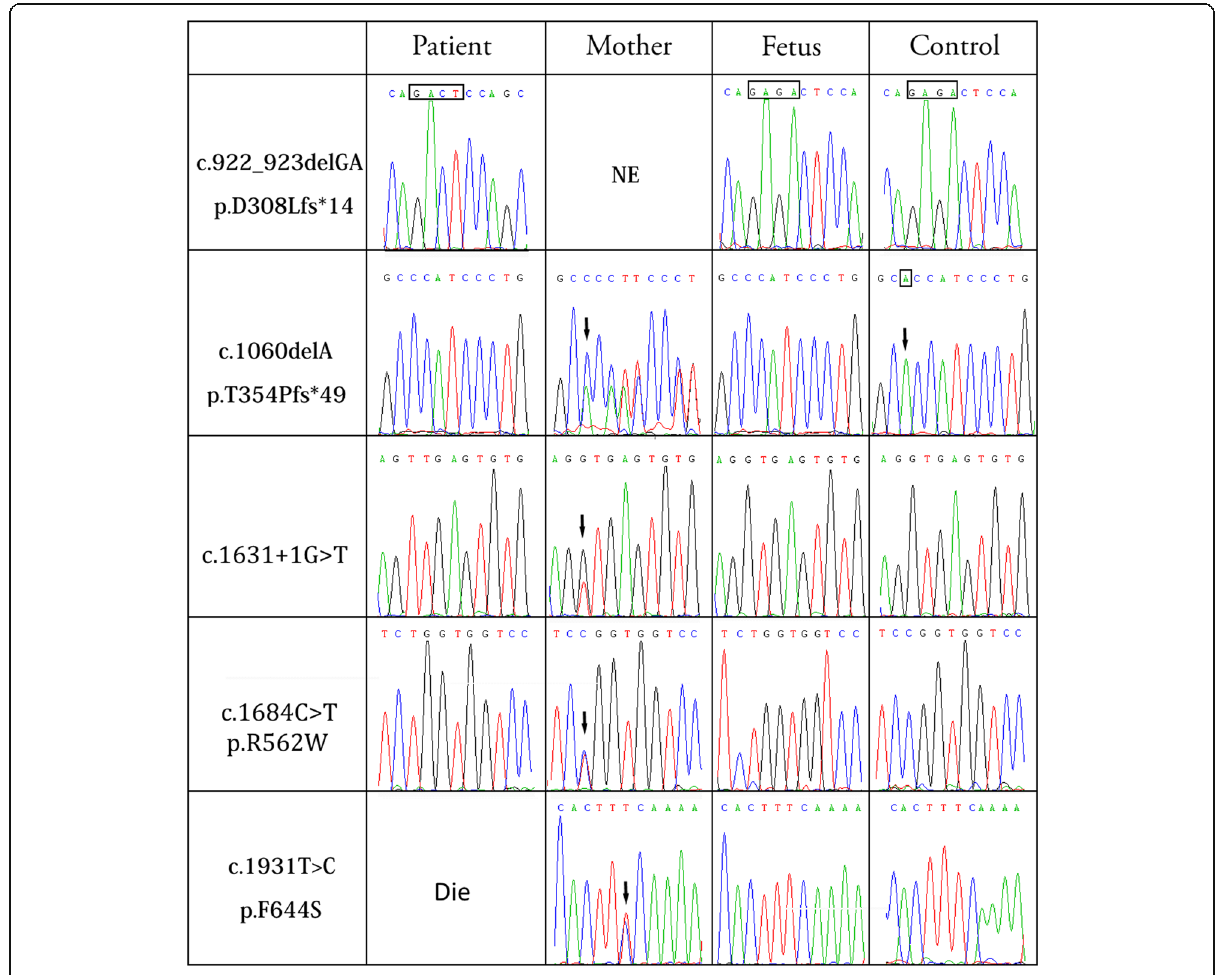
Fig. 2 Sequence chromatograms of BTK variants in five prenatal pedigrees and controls